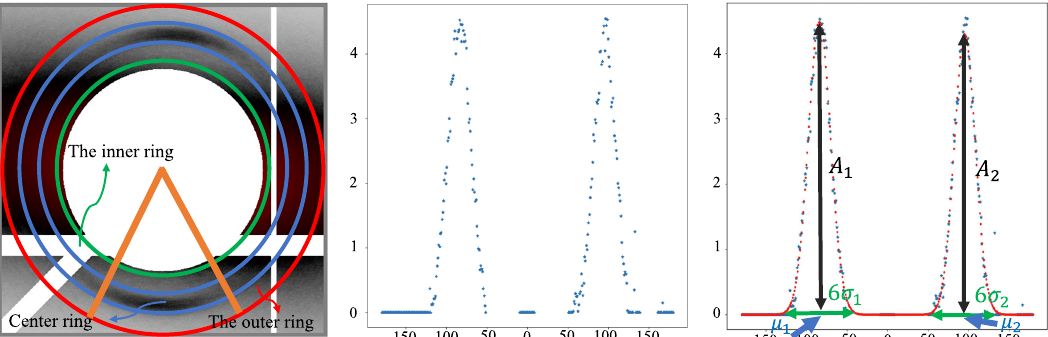
Fig. 10 Schematics of radial integration (left), integration result (mid), and associated fi tting result with amplitude, mean, and standard deviation shown (right). The fi gure illustrates how the metrics of delta amplitude, delta mean, and delta standard deviation used in this work were de fi ned and calculated. Perfectly symmetrical distribution of diffraction arcs implies 180 degrees for delta mean. Units along horizontal axes are in